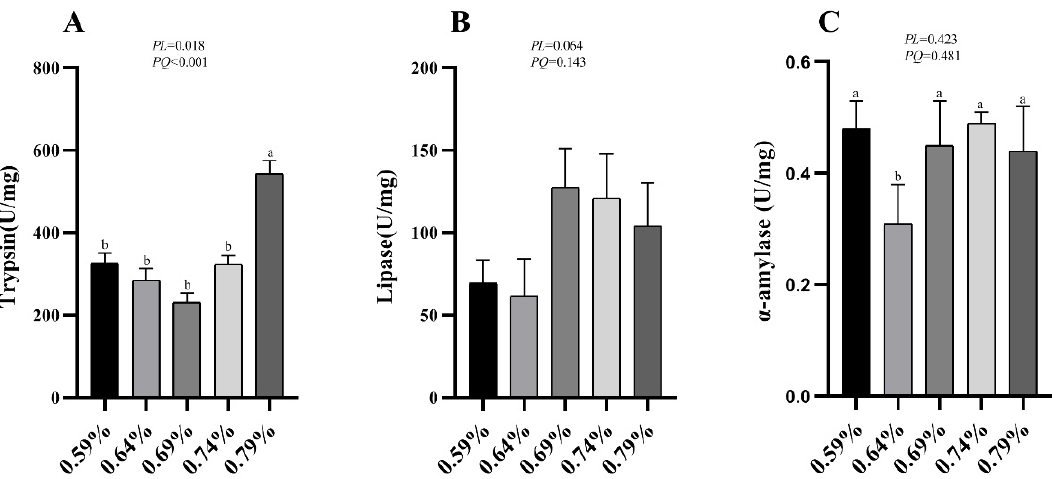
Figure 2. Effects of dietary valine levels on activities of duodenum digestive enzymes of laying hens. Values are represented as the mean and SEM (n = 8). Means with different superscript letters (a, b) within a column differ significantly ( p < 0.05).